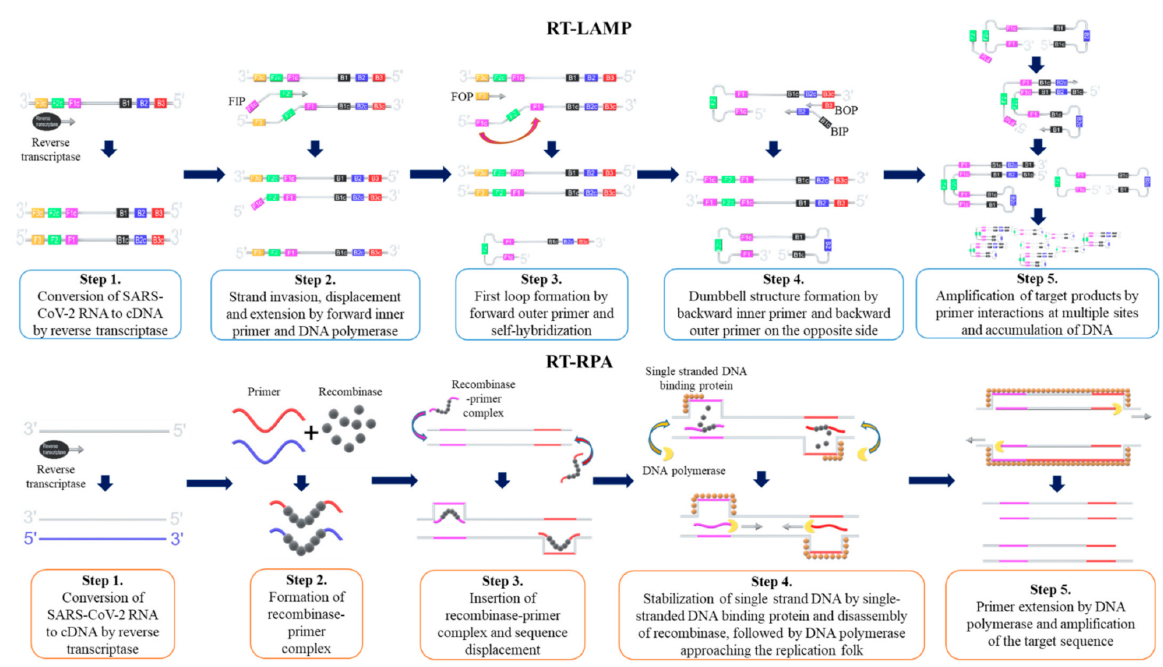
Figure 2. Schematic procedure of reverse transcription loop-mediated isothermal amplification (RT-LAMP) and reverse transcription recombinase polymerase amplification (RT-RPA). FIP = Forward Inner Primer, FOP = Forward Outer Primer, BIP = Backward Inner Primer, BOP = Backward Outer